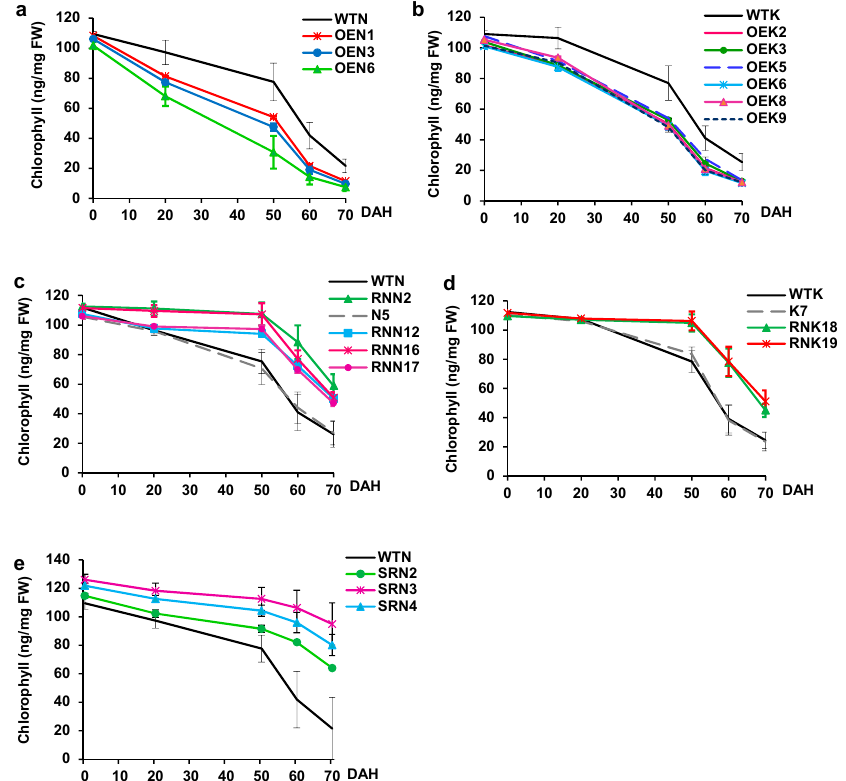
Figure 6. Chlorophyll contents in the flag leaves after heading. Central portions of flag leaves of wild-type and transgenic-lines were excised and the chlorophyll was extracted at the indicated days after heading (DAH). Triplicated samples were analyzed from single plants. Mean values with standard deviations are shown. Wild-type, OE lines of Nipponbare ( a ) and Kinmaze ( b ), RNAi lines of Nipponbare ( c ) and Kinmaze ( d ), and SRDX lines of Nipponbare ( e ). Names of plant lines are shown in Figure 4.